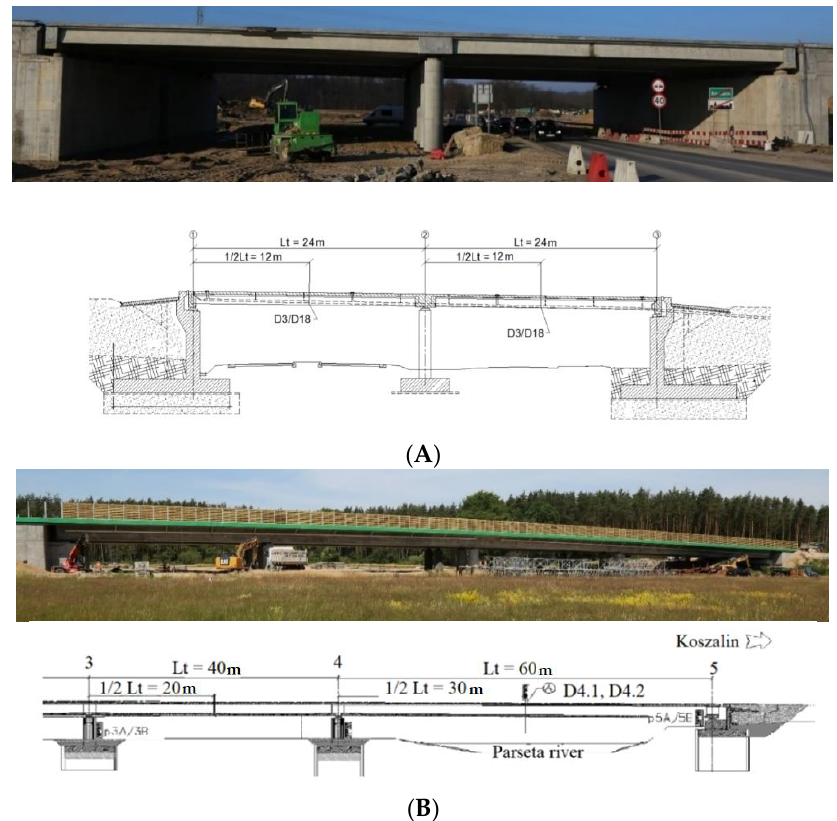
Figure 1. Side view of the bridge with its cross- section ( A ) WD-113, ( B ) M78.